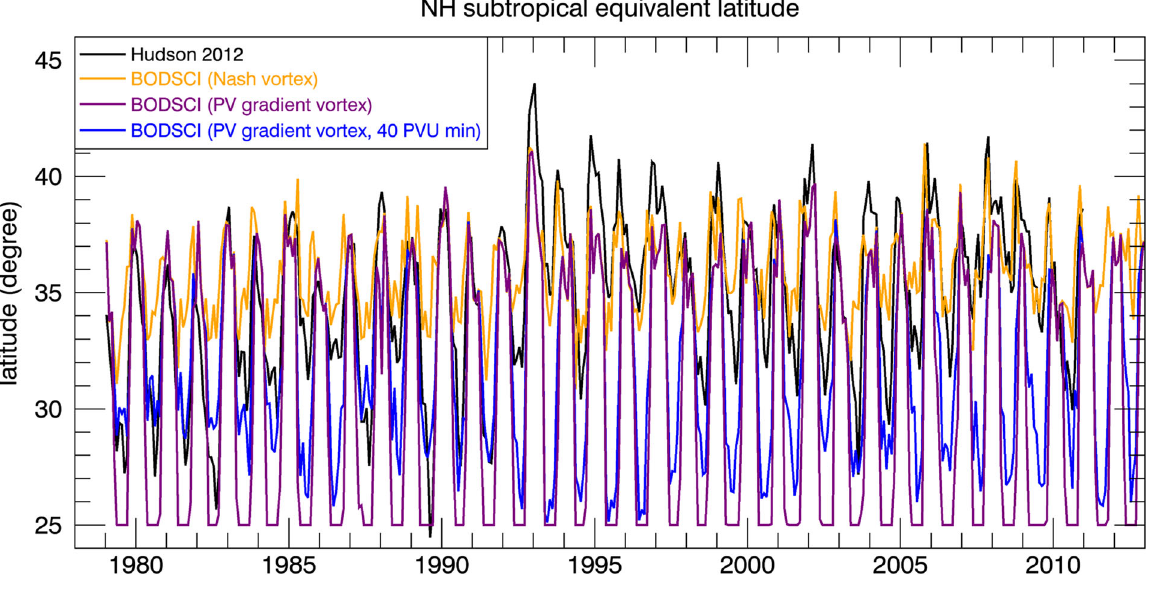
Fig. 2 NH tropical width sensitivity to polar vortex masking. Calculations from Hudson 2012 are in black, and the colored lines show the NH subtropical edge latitude computed from three different vortex identification algorithms